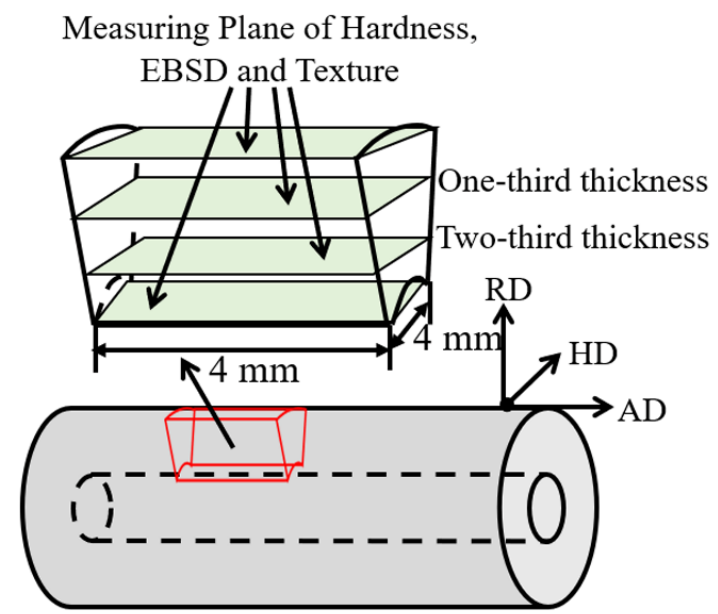
Figure 2. Measuring plane of hardness, EBSD and texture.